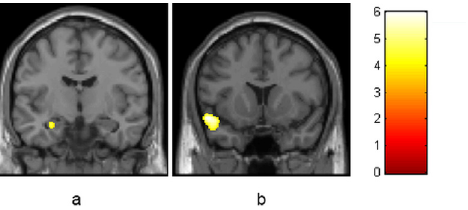
Fig 2. Negative correlation between use per week in grams at follow-up and grey matter volume in the whole brain analysis in the CB group. There are two significant clusters, one in the hippocampus/ amygdala (cluster size = 118, pFWE = .044, x,y,z = -27,-10,-20; Fig 2a) and one in the superior temporal gyrus (cluster size = 518, pFWE = .044, x,y,z = -52,11,-15; Fig 2b). Images are coronally depicted in radiological convention (i.e. subject ’ s left is image ’ s